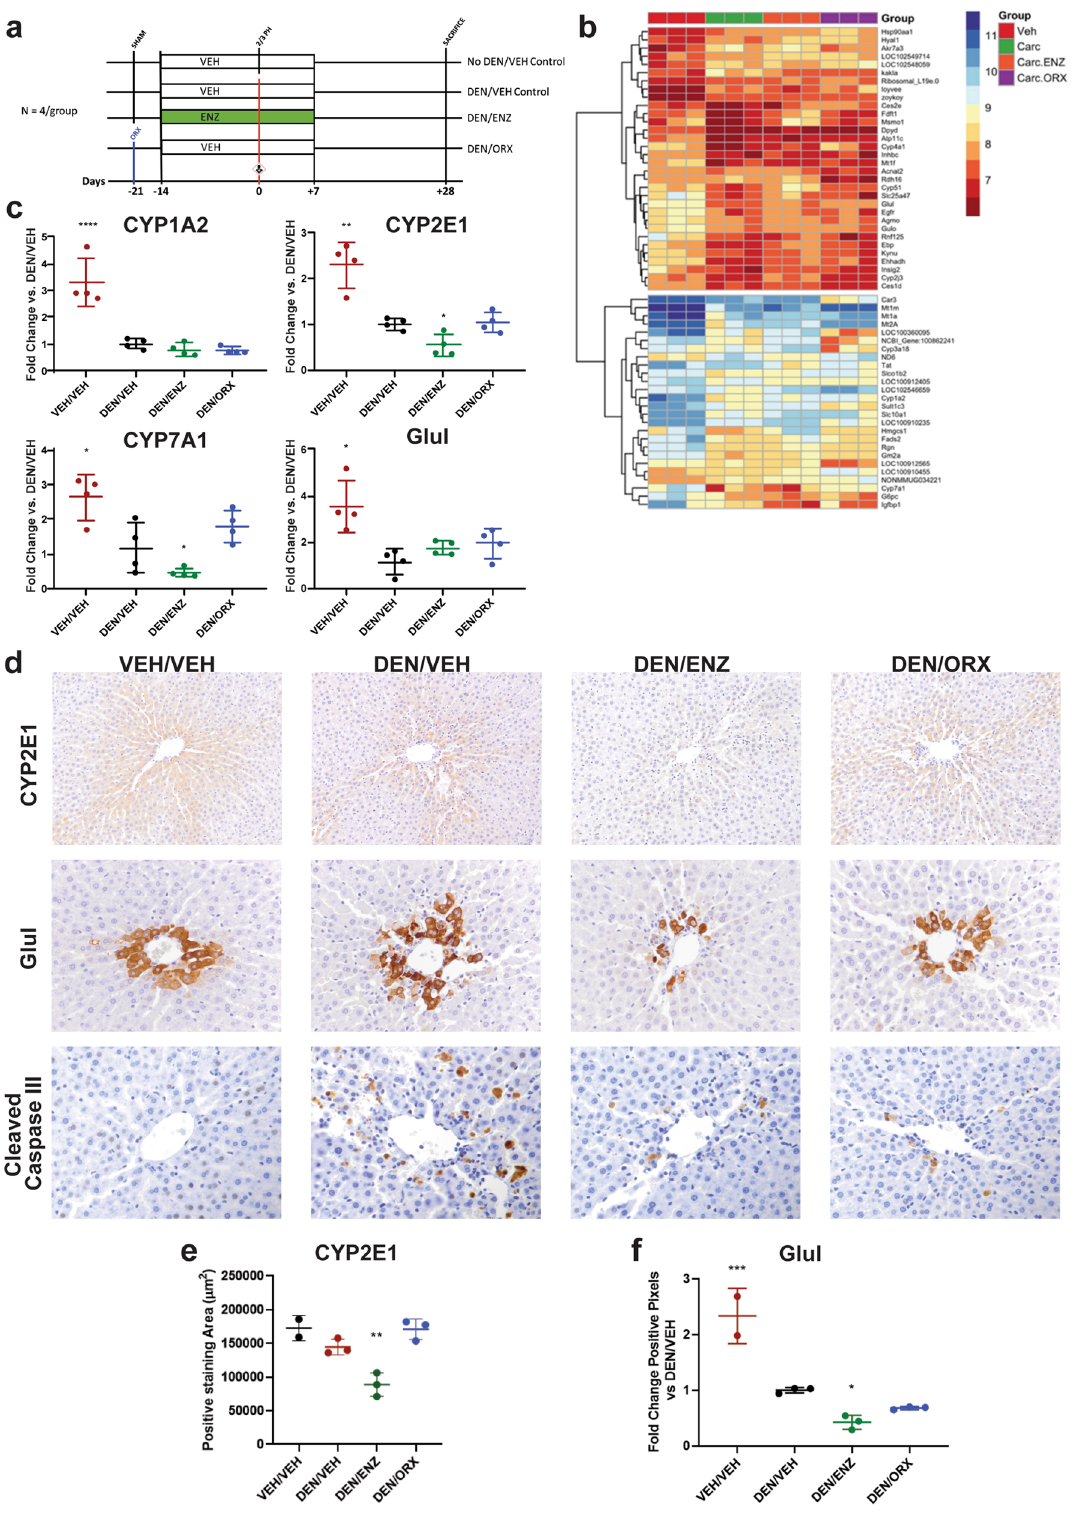
Figure 2. Preventive anti-androgen treatments inhibit DEN carcinogenesis in a model specific manner. ( a ) Study Design—simplified timeline highlighting preventive anti-androgen interventions for follow-up study. ENZ = 30 mg/kg daily oral gavage doses. Note addition of non-DEN, VEH-treated, PH only control group. ( b ) Heatmap highlighting gene expression (row) by animal (column) within treatment group (column color). Red = downregulation; Blue = upregulation. ( c ) qRT-PCR confirmation of expression of Wnt/β- catenin targets CYP1A2, CYP2E1, CYP7A1, Glul. Preventive ENZ suppresses CYP2E1 and CYP7A1 expression. ( d ) Zonal distribution of CYP2E1 (200x) and Glul (400x) is reduced by preventive ENZ; ENZ and ORX suppress DEN induction of CCIII (400x). ( e ) ENZ reduces CYP2E1 positive staining area (quantification of 2D CYP2E1). ( f ) ENZ reduces Glul expression (quantification of 2D Glul) Quantitative, positive pixel analysis supports this conclusion. All analyses are One-Way ANOVA, Dunnett’s Multiple comparisons (vs. DEN/VEH): * p < 0.05, ** p < 0.01, *** p < 0.001, **** p < 0.0001. All data represented as mean ± standard